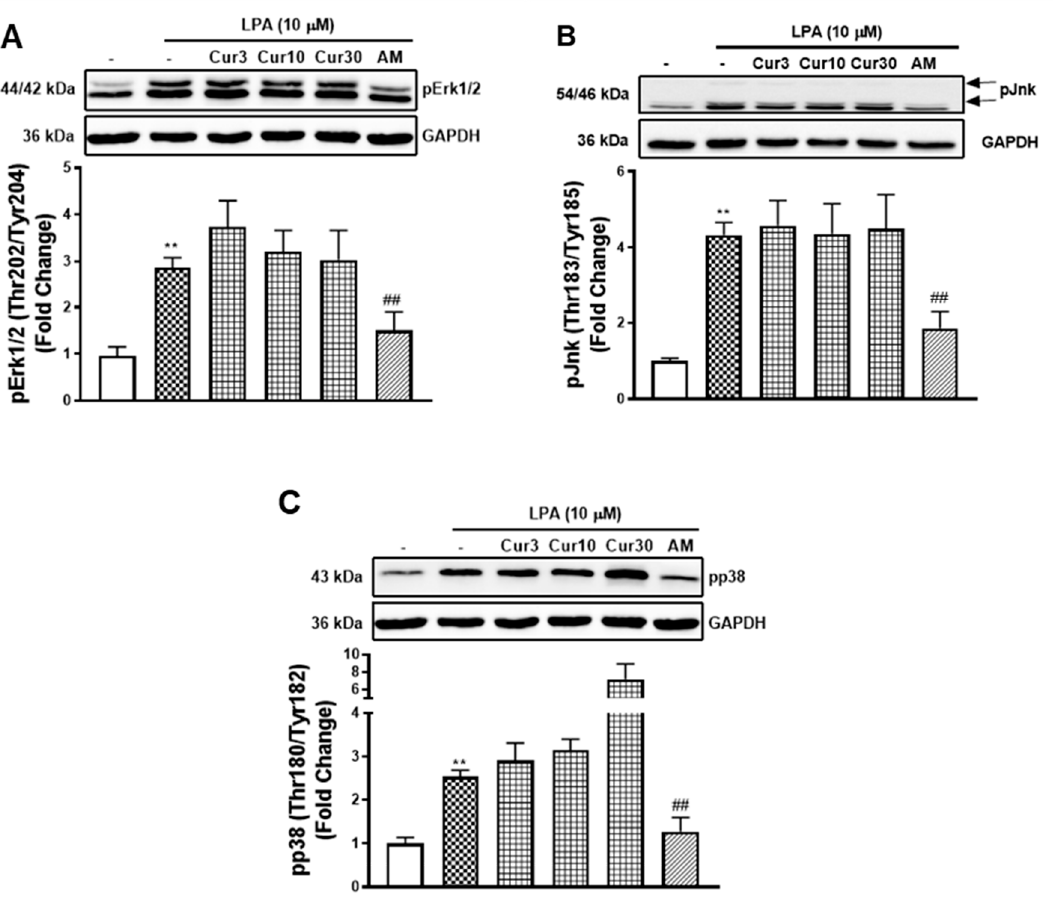
Figure 5. The effect of curcumin on LPA stimulated MAPK signalling. VSMCs were pre-incubated with 3, 10 and 30 µM curcumin for 30 min before the treatment of LPA (10 µM) for 30 min. Blots were probed with primary antibodies specific to ( A ) phospho-Erk (Thr202/Tyr204) (1:4000), ( B ) phospho-Jnk (Thr183/Tyr185) (1:1000), ( C ) phospho-p38 (Thr180/Tyr182) (1:2000) and secondary HRP conjugated rabbit IgG antibody (1:2000). Blots are representative of three-independent experiments. Figures A and C share the same blot of GAPDH. Histogram represents band density expressed as fold per basal (presented as mean ± SEM) after normalised to GAPDH. Statistical significance was determined by one-way ANOVA, followed by least significant difference post-hoc analysis. ** p < 0.01 versus basal; ## p < 0.01 versus LPA only treated